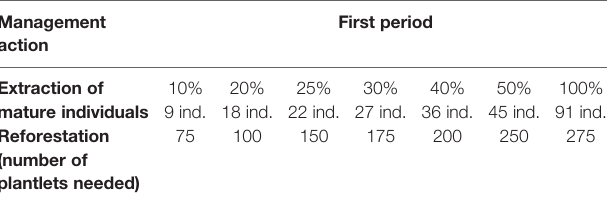
TABLE 6 | Different combinations of thresholds of management actions to maintain l above 1 in the population Icuacato in the fi rst monitoring period.